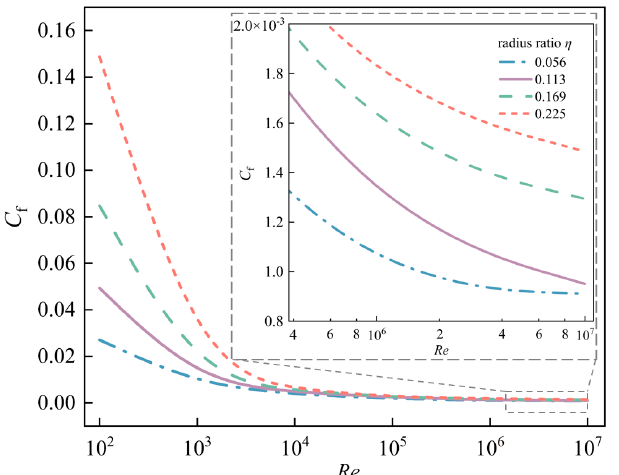
Figure 11. Skin friction coefficient C f versus Re for η ranging from 0.056 to 0.225 at Ra = 0.8 μ m. Table 4. Values of C f versus Re for η ranging from 0.056 to 0.225 at Ra = 0.8 μ m.